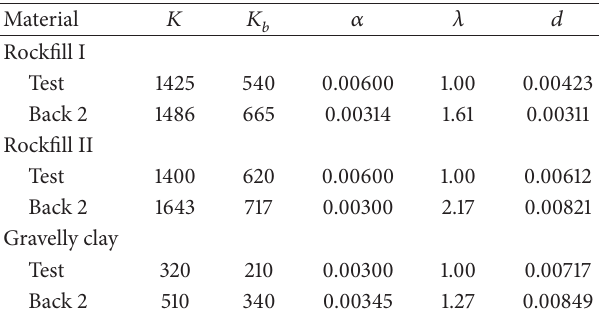
Table 3: Main E-B and creep model parameters.